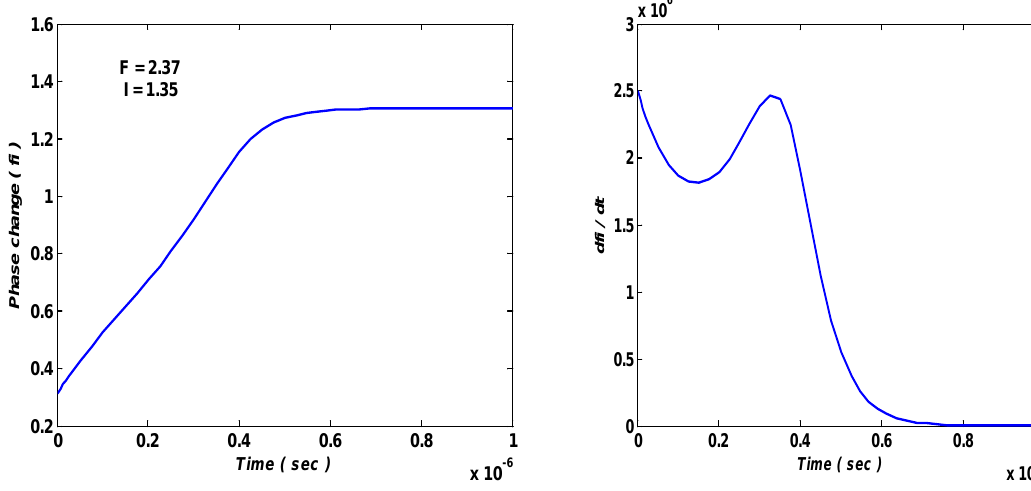
Fig.5: The change in the driving term in a low finesse etalon (F=2.37) using switching intensity (I=1.35) and the initial detuning